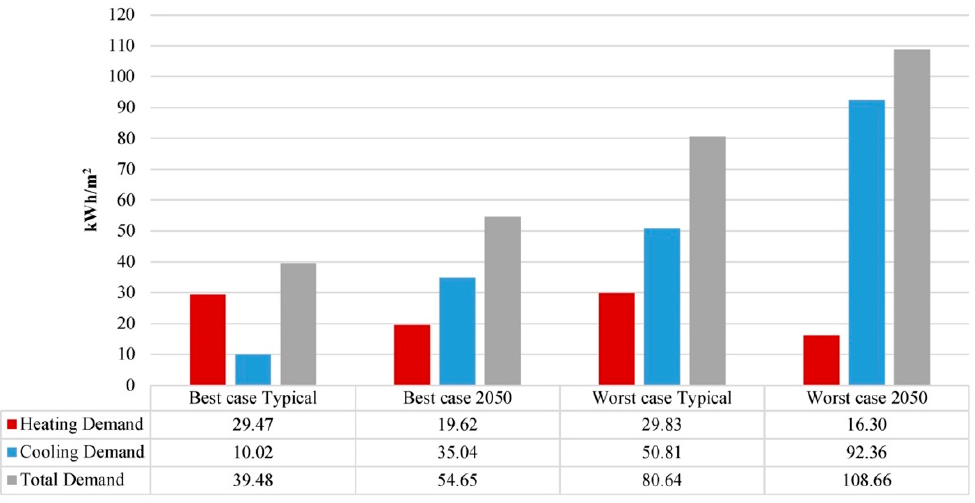
Figure 10. Energy demand under typical climatic conditions and the 2050 climate scenario.